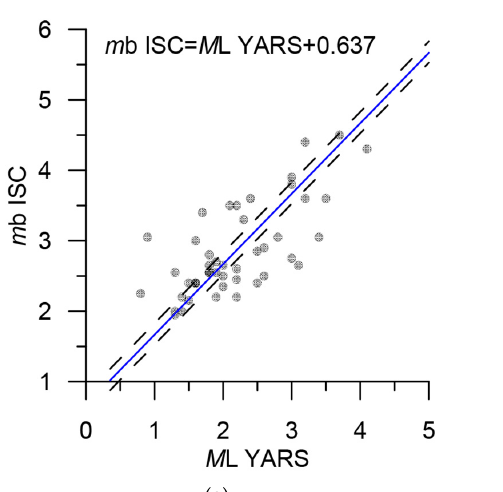
Figure 16. Correlation ratios “shift” of the magnitudes YARS and mb ISC . ( a ) ML YARS . ( b ) MSV YARS . The dashed lines show 95% confidence